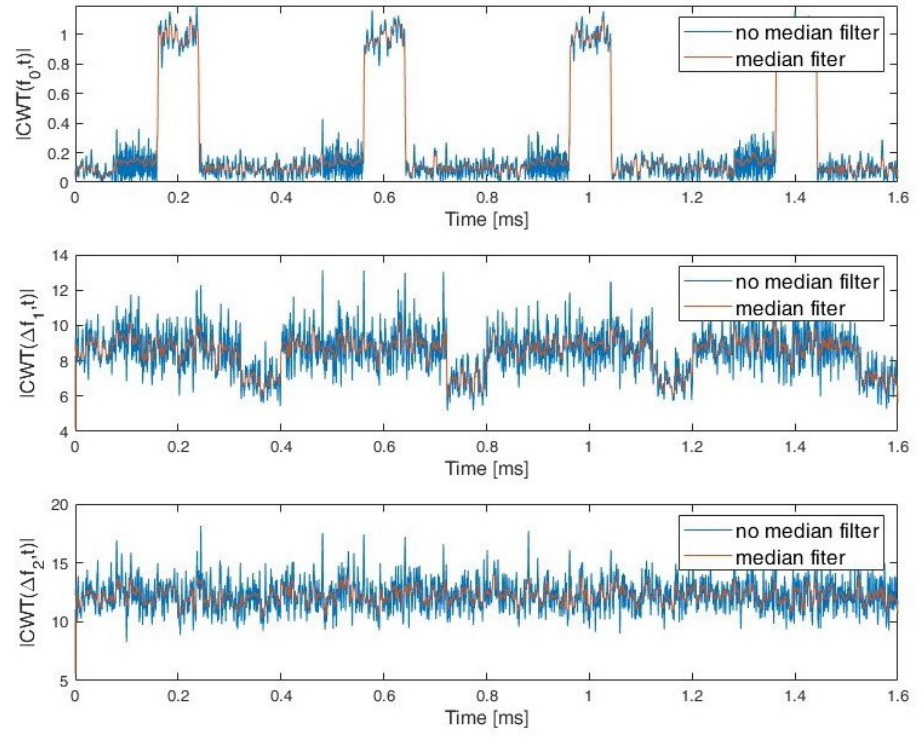
Figure 8. CWT frequency cut for f o ∼ = f c and sum of CWT coefficients range ∆ f 1 and ∆ f 2 .